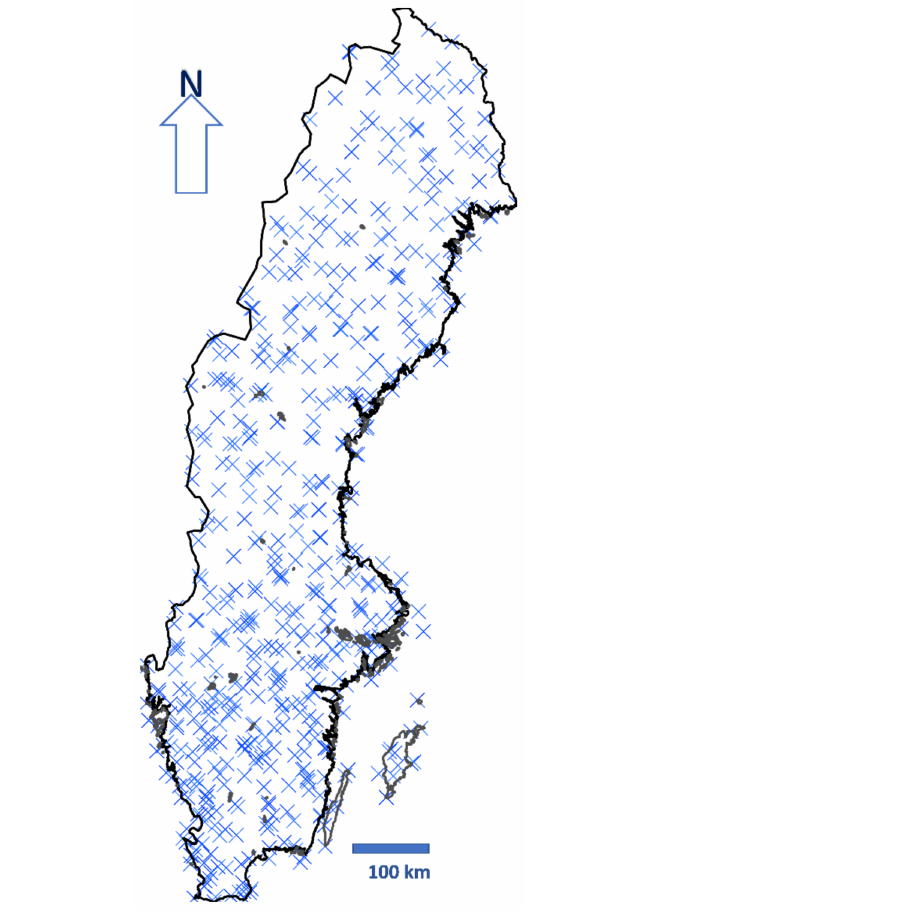
Figure 7. Part of the Swedish network of climate stations. These 588 stations were used for the development of the rainfall intensity maps 8a–d covering